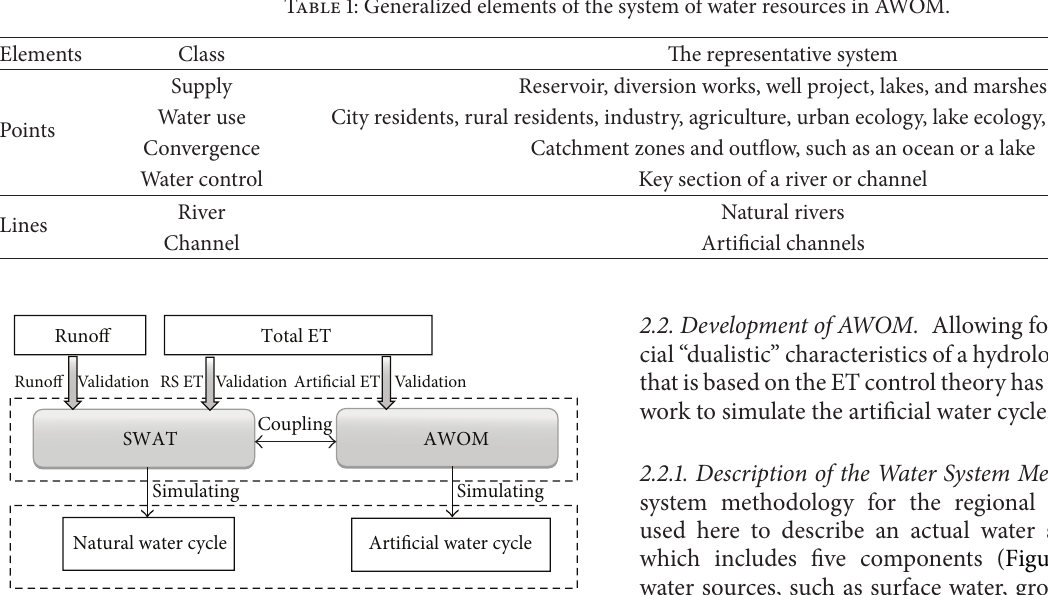
Figure1:ThestructureoftheWASmodel(RSETisETdataretrieval with remote